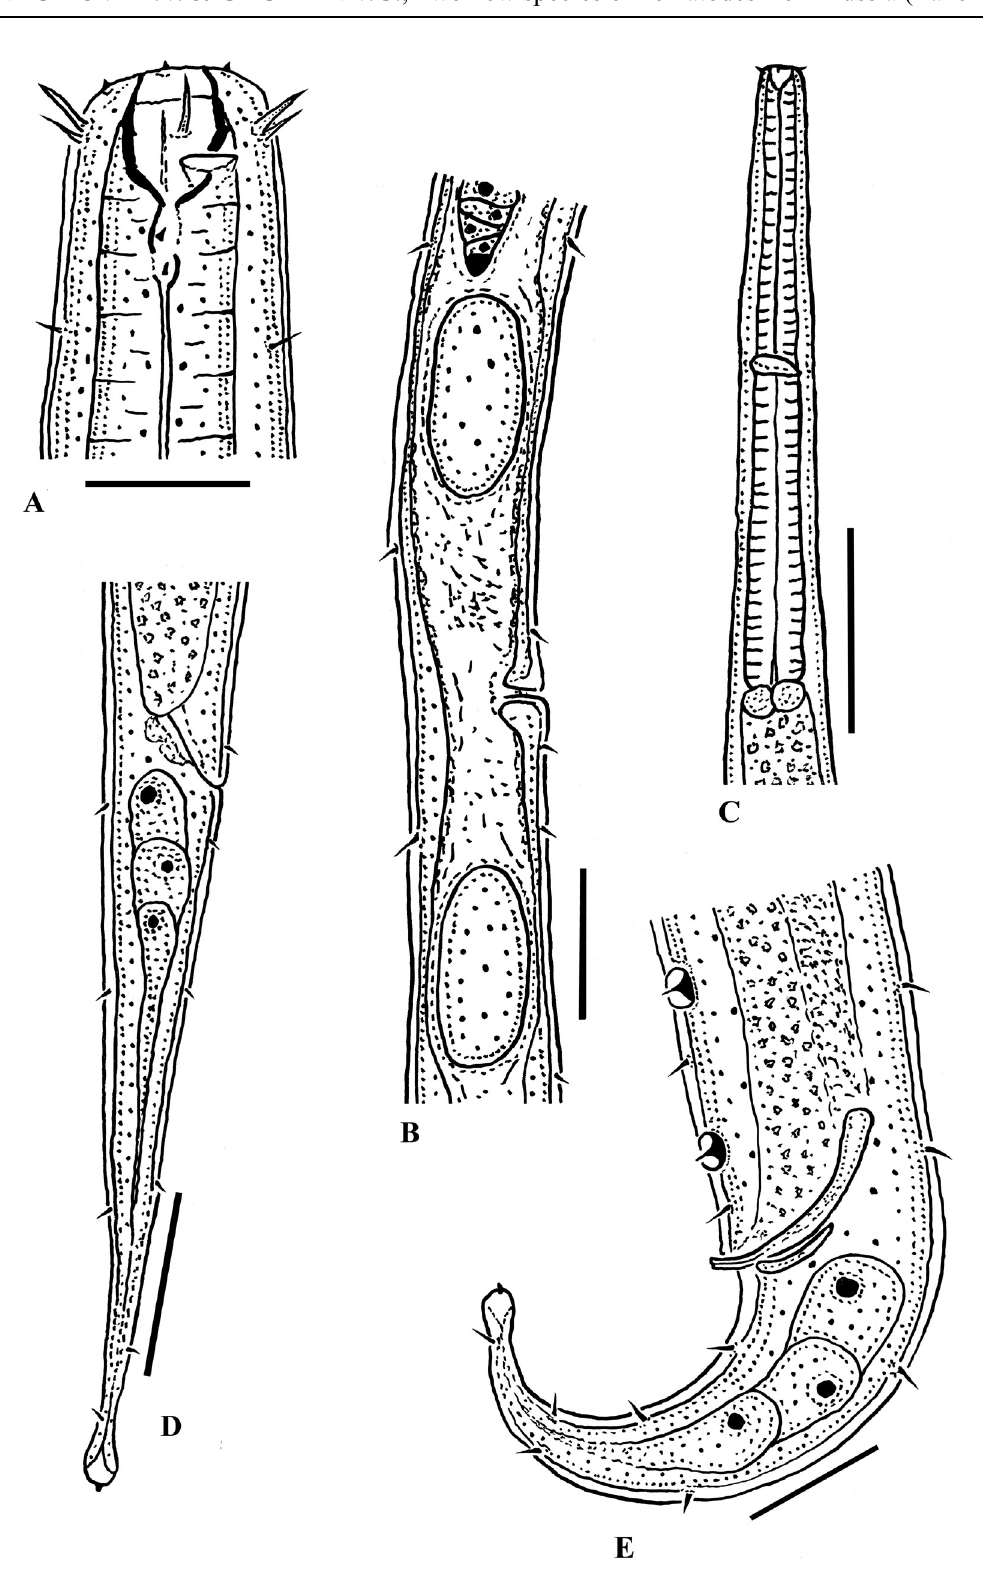
Fig. 3. Tobrilus juliae sp. nov. A . Male anterior end. B . Female vulva region. C . Male pharyngeal region. D . Female posterior body end. E . Male posterior body end. Scale bars: A = 15 µm; B = 50 µm; C = 100 µm; D = 40 µm; E = 30